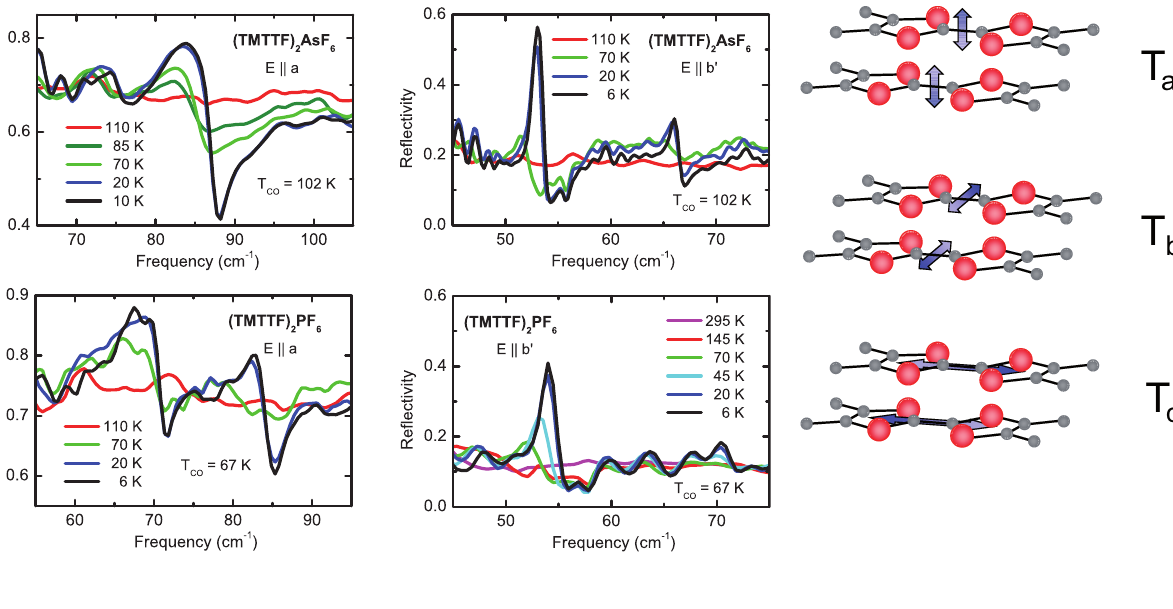
AsF (upper panels) and 2 6 PF . The excitations are mainly 2 6 , T and T sketched on the right side for the a b c